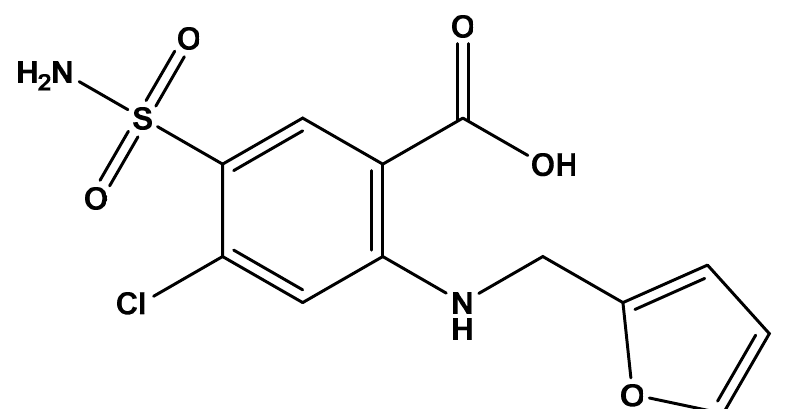
Figure 1. Chemical structure of furosemide. Reproduced with permission from Kalhapure, International Journal of Pharmaceutics; published by Elsevier. 2012